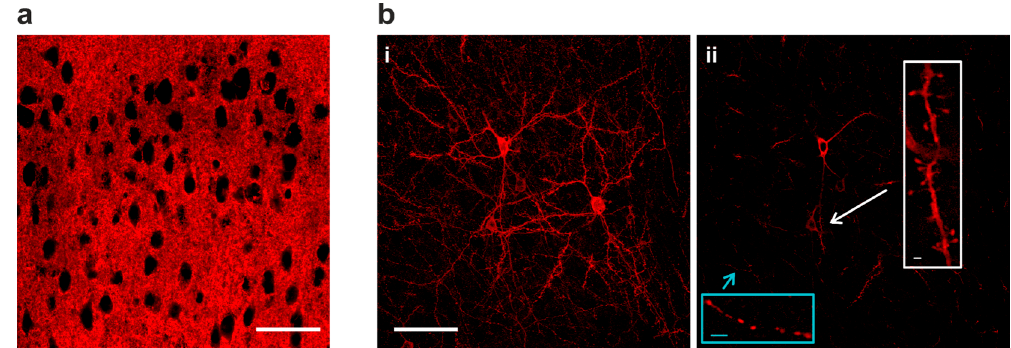
Figure 2. Sparse GEVI expression in vivo resolves subcellular structures. ( a ) At full expression density, GEVI optical signals are difficult to be assigned to individual neurons due to intermingled neuronal processes in dense populations. ( b ) Sparse Golgi staining-like GEVI expression density resolves single cells and subcellular morphologies ( i ) A 15 µm stack projection of three individual layer II/III pyramidal neurons. ( ii ) Single-plane image from the stack in ( b-i ). GEVI targeting achieves optimal membrane expression, and is capable of resolving subcellular structures in vivo, including axonal boutons (blue inset) and dendritic spines (white inset). Image scale bar = 50 µm; inset scale bar = 2 µm.